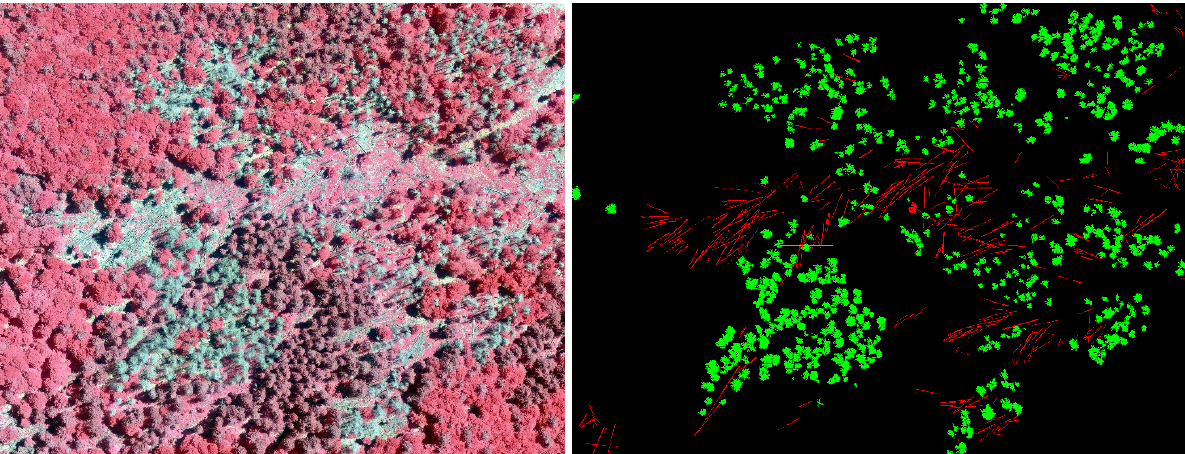
Figure. 3 The training data (left) and its corresponding labelled image (right), the red label means the fallen dead trees and the green means the standing dead trees